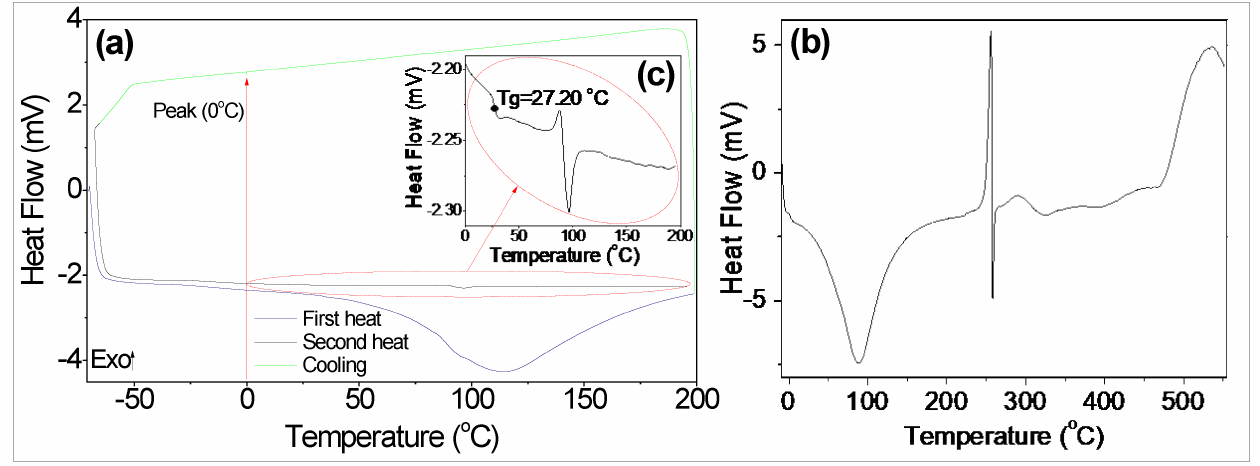
Figure 4. DSC of BG. ( a ) Heating–cooling–heating cycles; ( b ) DSC of the gum for the temperature range of − 10–550 ◦ C; and ( c ) glass transition temperature (Tg). Table 2. Temperatures and changes in enthalpy associated with the heating and cooling stages of buriti tree gum. Event Peak Final Heat stage First heating